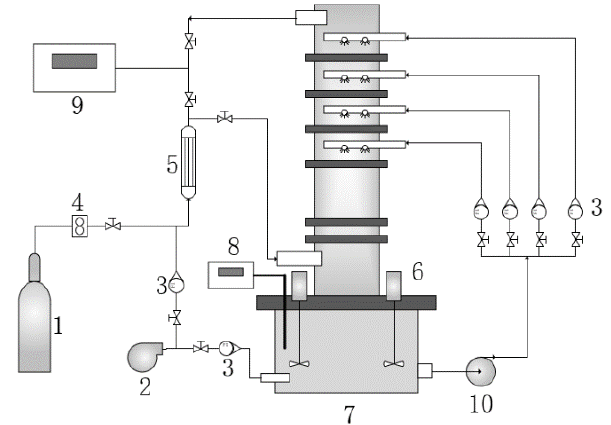
Figure 2. Scheme of desulfurization tower. 1—SO 2 cylinder, 2—blower, 3—rotor flowmeter,